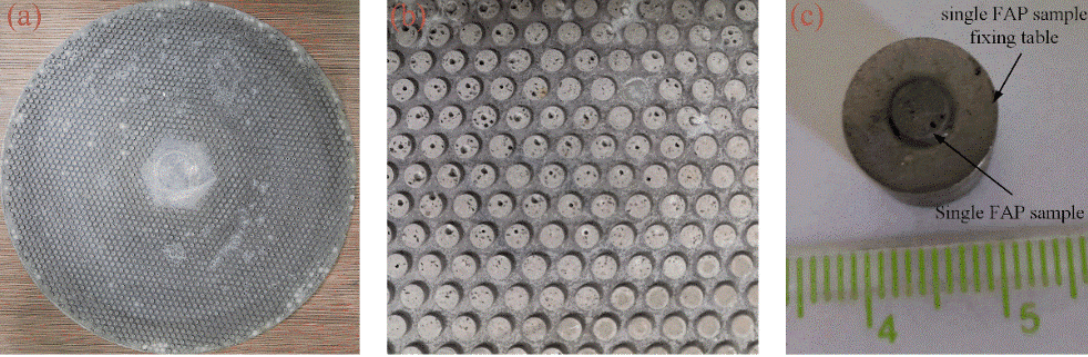
Figure 3. Polishing pad measurement sample: ( a ) FAP; ( b ) FAP local magnification; ( c ) FAP sample.